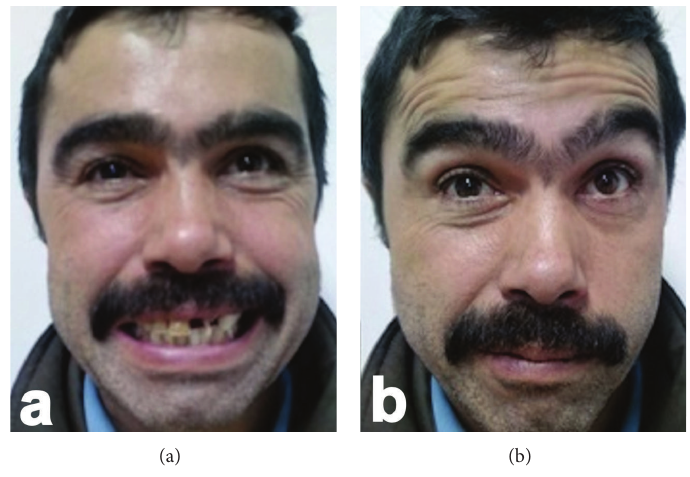
Figure 2: Postoperative view of the patient at the 1-year